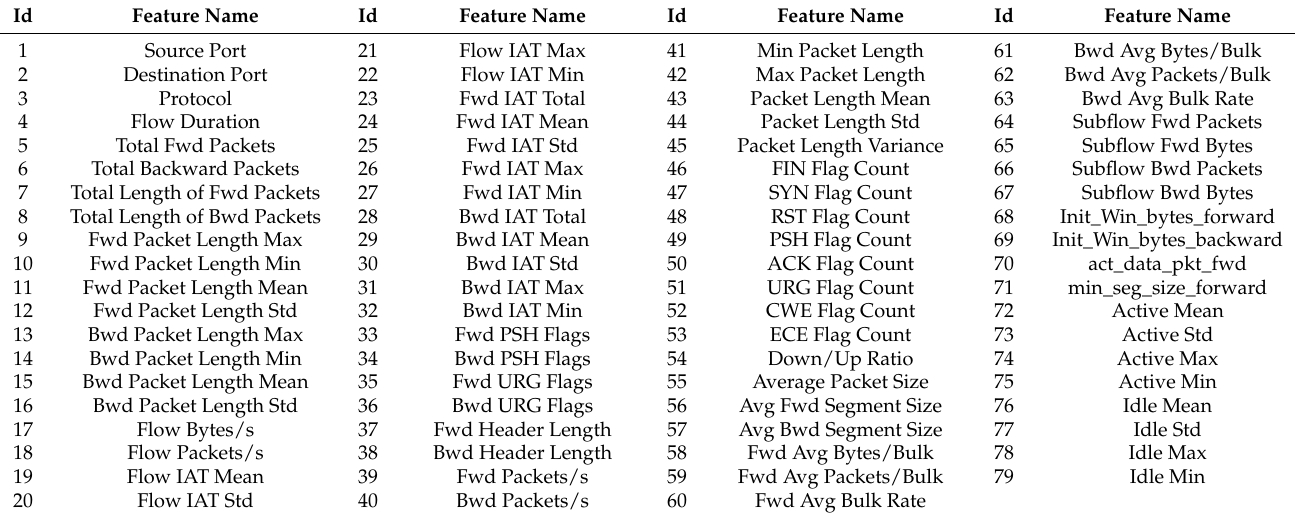
Table 1. Dataset characteristics and their coding.